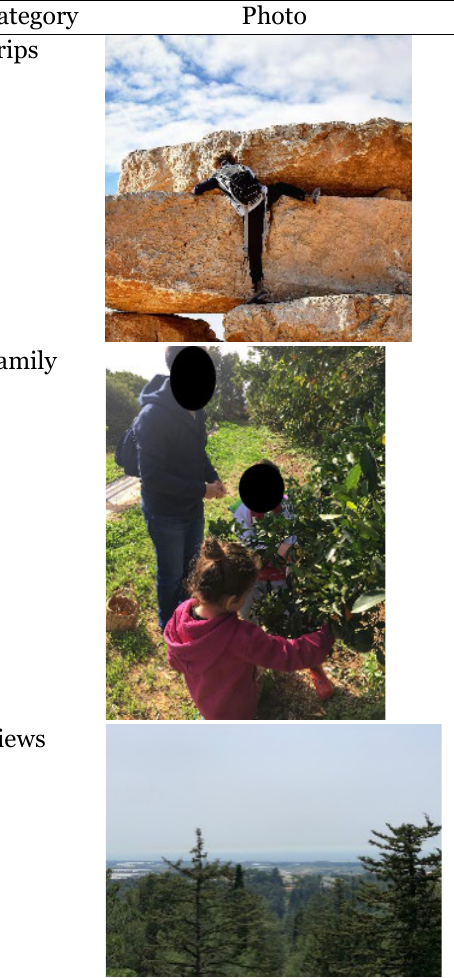
Categories and Photos From the A Sense of a Place